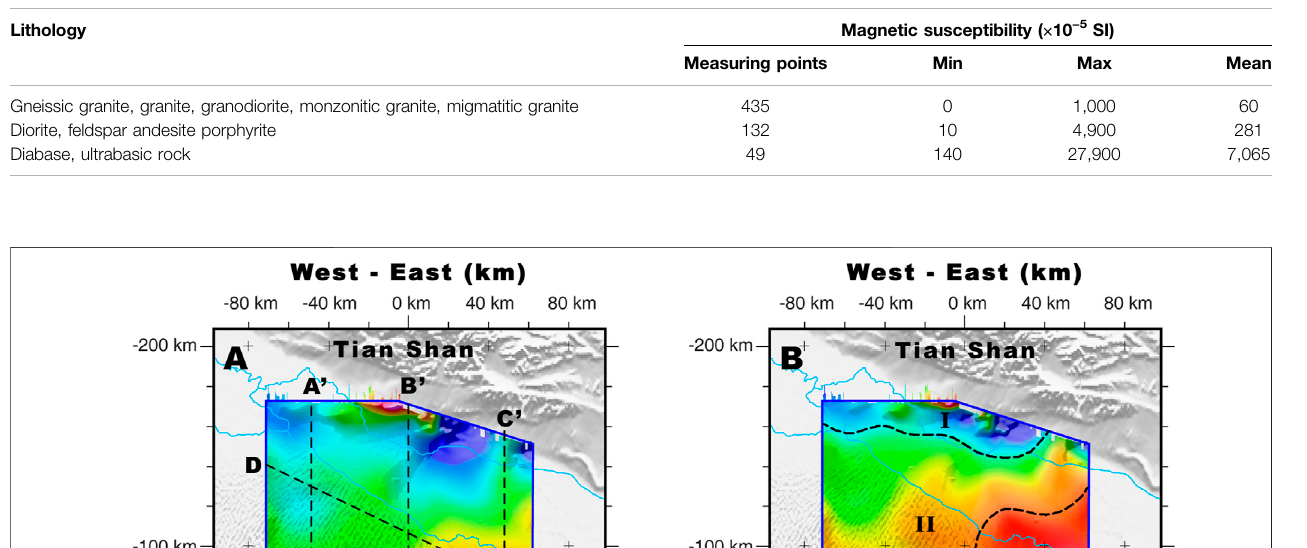
Frontiers in Earth Science |